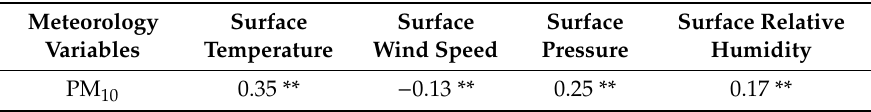
Table 1. Correlation coe ffi cients between the daily mean PM 10 concentration and the surface temperature, surface pressure, surface wind speed, and surface relative humidity for 2002–2017 in winter. ** denotes significance at the 99% confidence